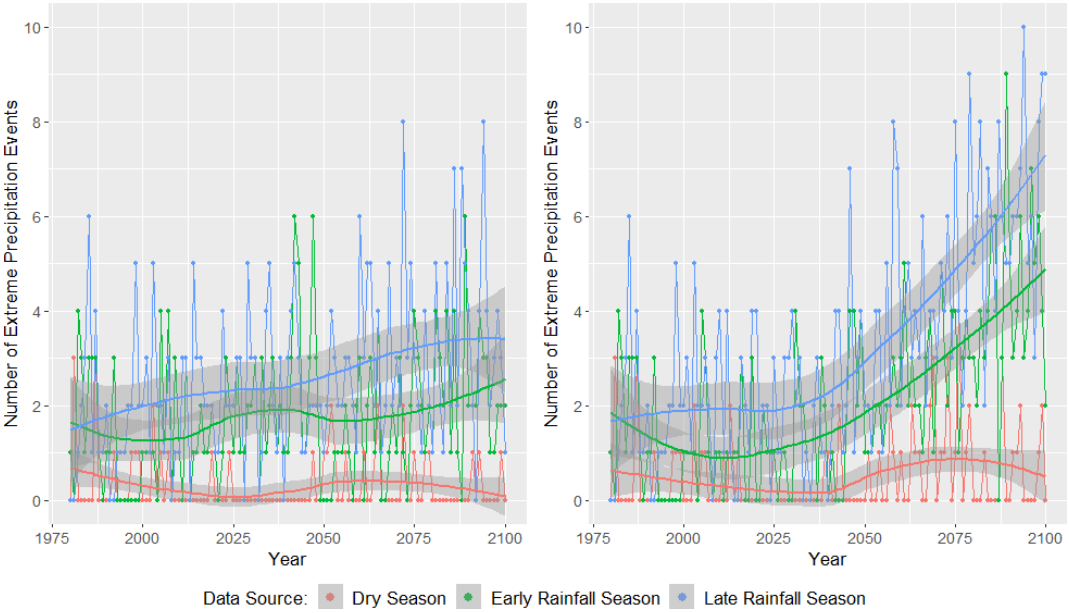
Figure 15. Total number of extreme rainfall (ER) events (island daily average rainfall > 29 . 90mm) by season for the CanESM2’s RCP4.5 forcing scenario (left) and the RCP8.5 forcing scenario (right). The years 1980–2005 represent historical GHCN observations and are also included on these plots. This figure was created using Wickham